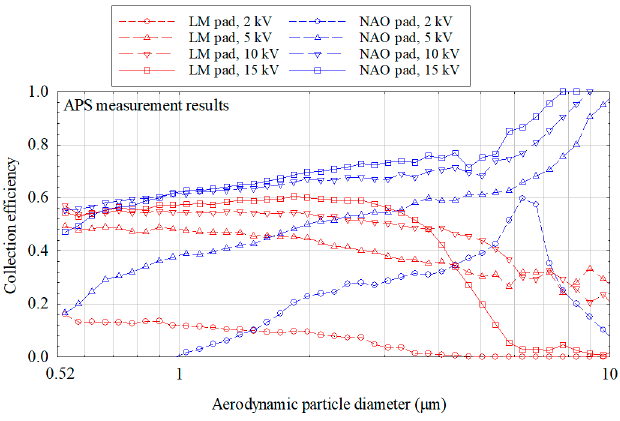
Figure 10. Size distributions of ESP collection efficiencies for various supplied voltages. The BWP collection efficiency increased as applied voltage increased from 2 kV to 10 kV for all particle sizes when using the NAO pad. The BWP collection efficiency was almost unchanged when the applied voltage was increased from 10 kV to 15 kV, whereas the BWP collection efficiency increased as the applied voltage was increased from 2 kV to 10 kV when using the LM pad. However, the collection efficiency above 4 µ m